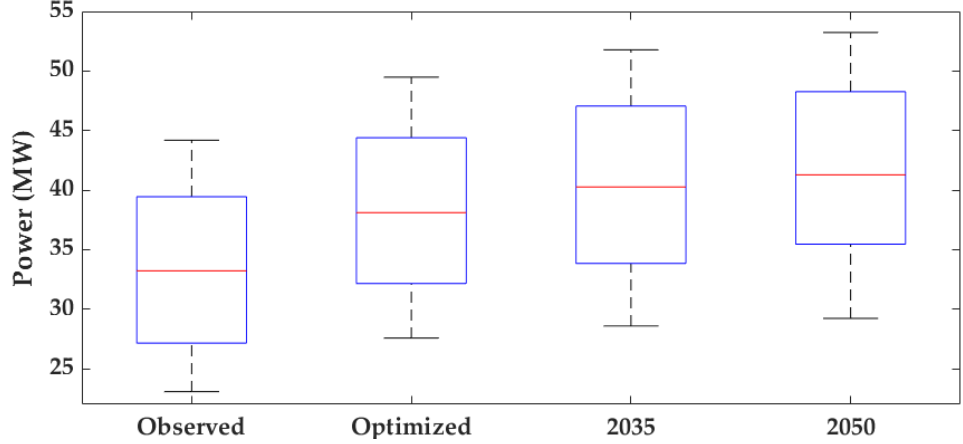
Figure 13. Boxplots of monthly hydropower generation of the Nashe watershed under different scenarios.